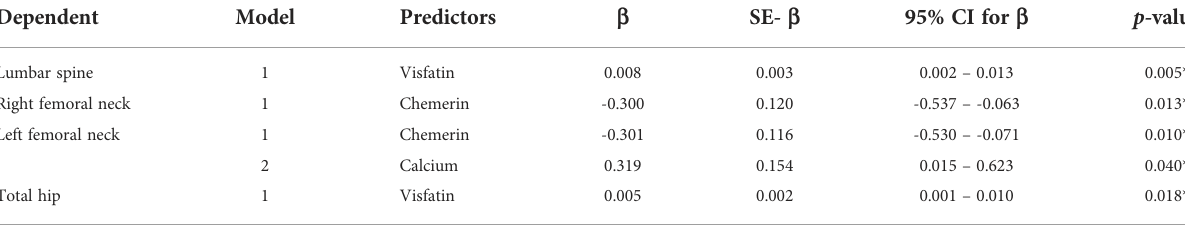
TABLE 2 Stepwise multiple regression analysis showing independent predictors of